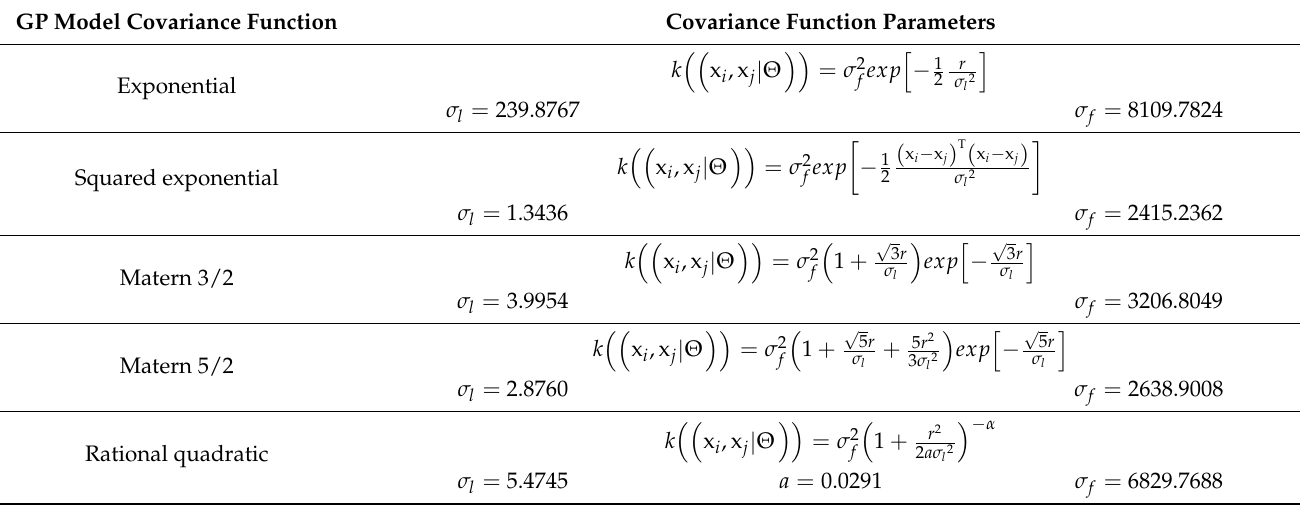
Table 2. Parameters of GPR model covariance